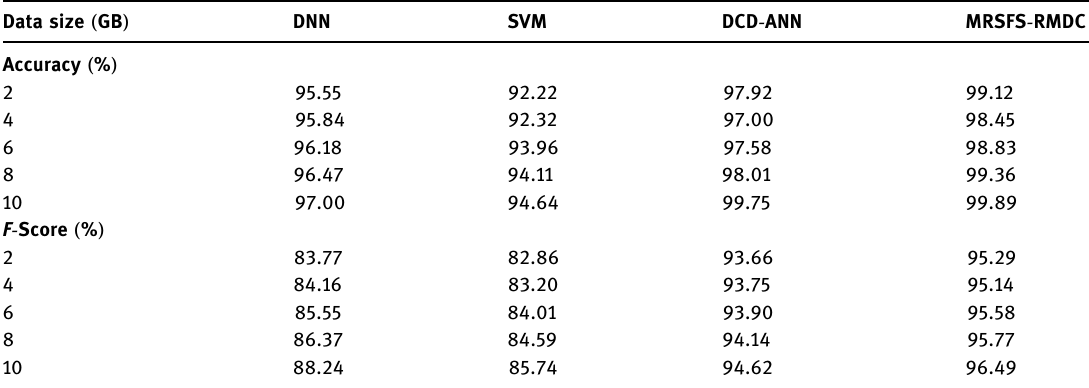
Table 3: Comparative analysis of MRSFS - RMDC model in terms of accuracy and F - score